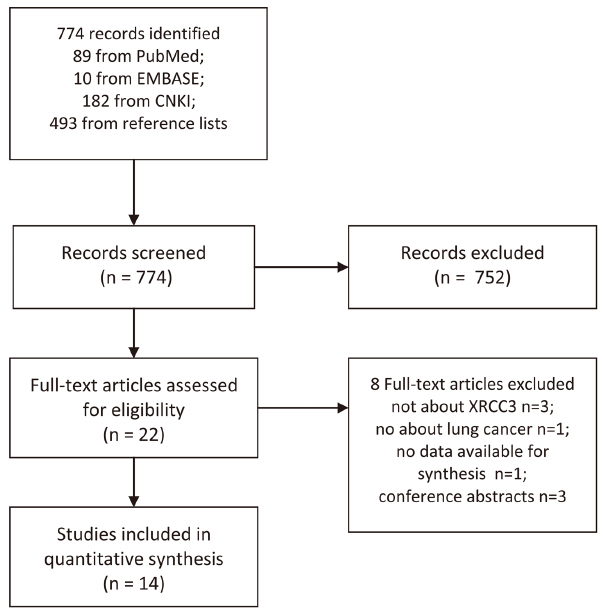
Figure 1. Flow Diagram.